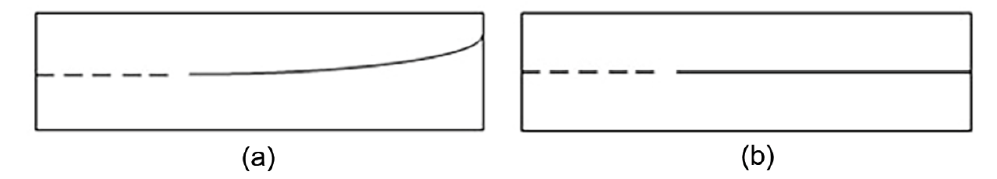
Figure 6. Schematic diagram of the fracture line exhibited by longitudinal ( a ) and transverse ( b ) specimens. ( b )